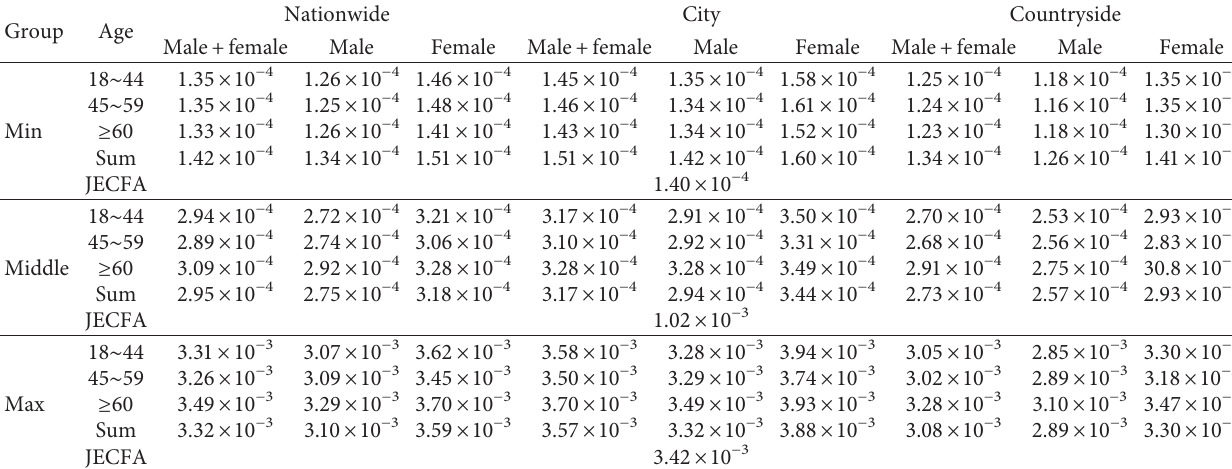
Table 5: The index of food safety of sulfonamides in animal products of